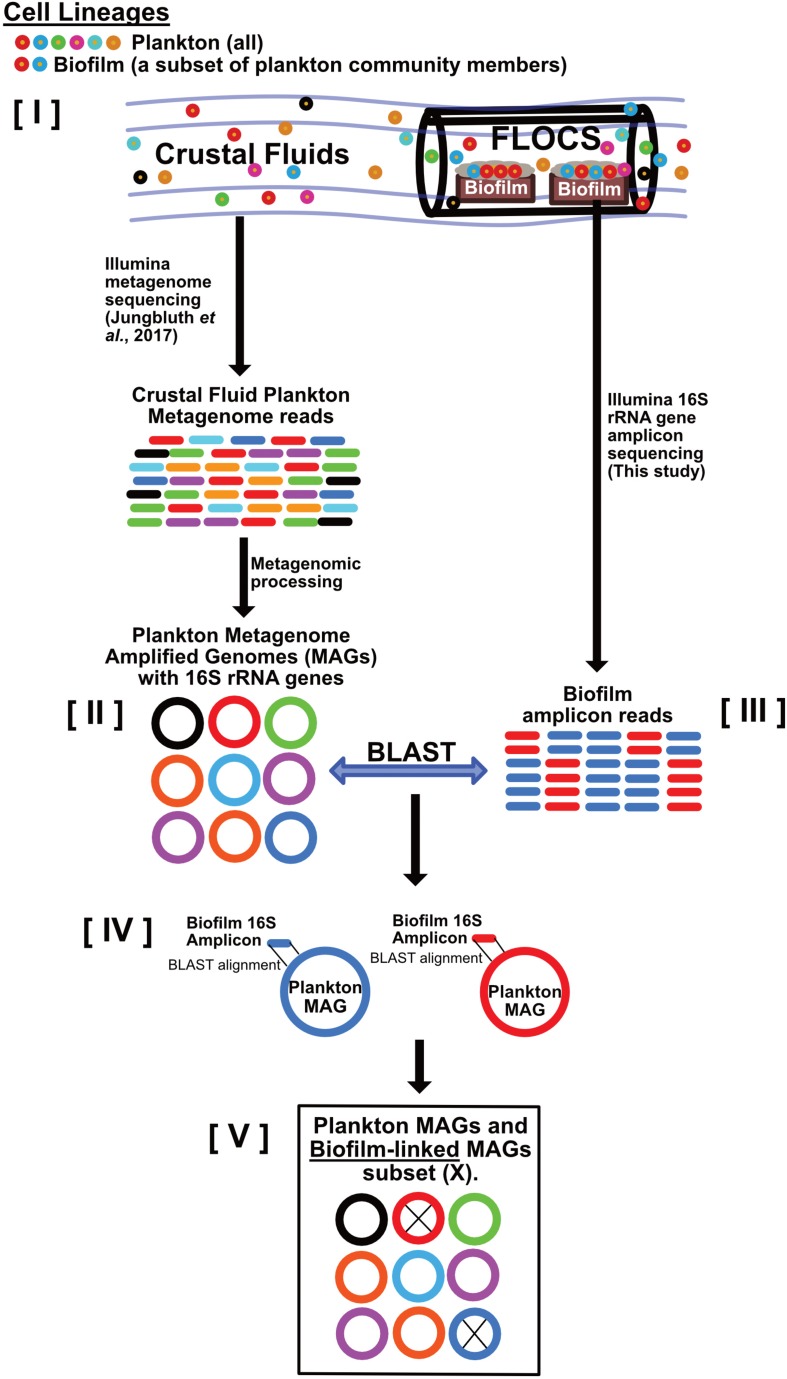
Schematic depicting our strategy for linking crustal fluid plankton MAGs to biofilm lineages. This workflow begins with the assumption that [I] all biofilm community members are also part of the crustal fluid community because FLOCS biofilms arise from crustal fluid inoculation. Metagenomic data from crustal fluid is processed into MAGs representing planktonic lineages [II]. Amplicons (16S rRNA gene) sequences from FLOCS biofilm [III] also represent planktonic lineages; however, these lineages transitioned from planktonic to biofilm lifestyles. Stringent local alignments [IV] between biofilm amplicons and the subset of plankton MAGs containing 16S rRNA genes reveal which planktonic lineages also reside in FLOCS biofilm and are thus considered “biofilm-linked” [V].